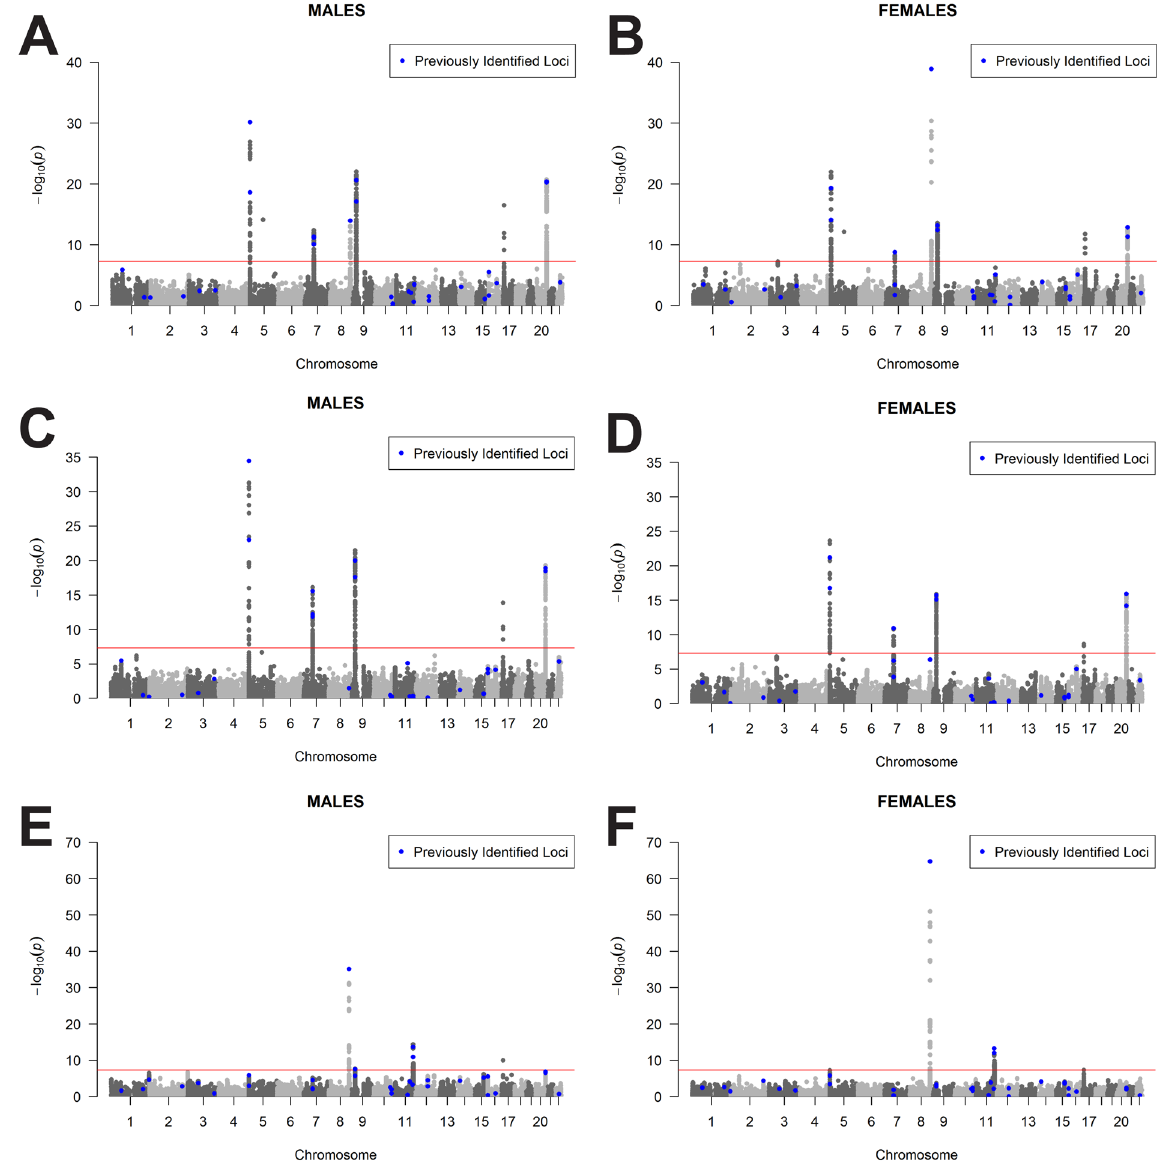
Figure 4. Manhattan plot of -log(p) values for all glioma in ( A ) males and ( B ) females, for GBM in ( C ) males and ( D ) females, and for non-GBM in ( E ) males and ( F )